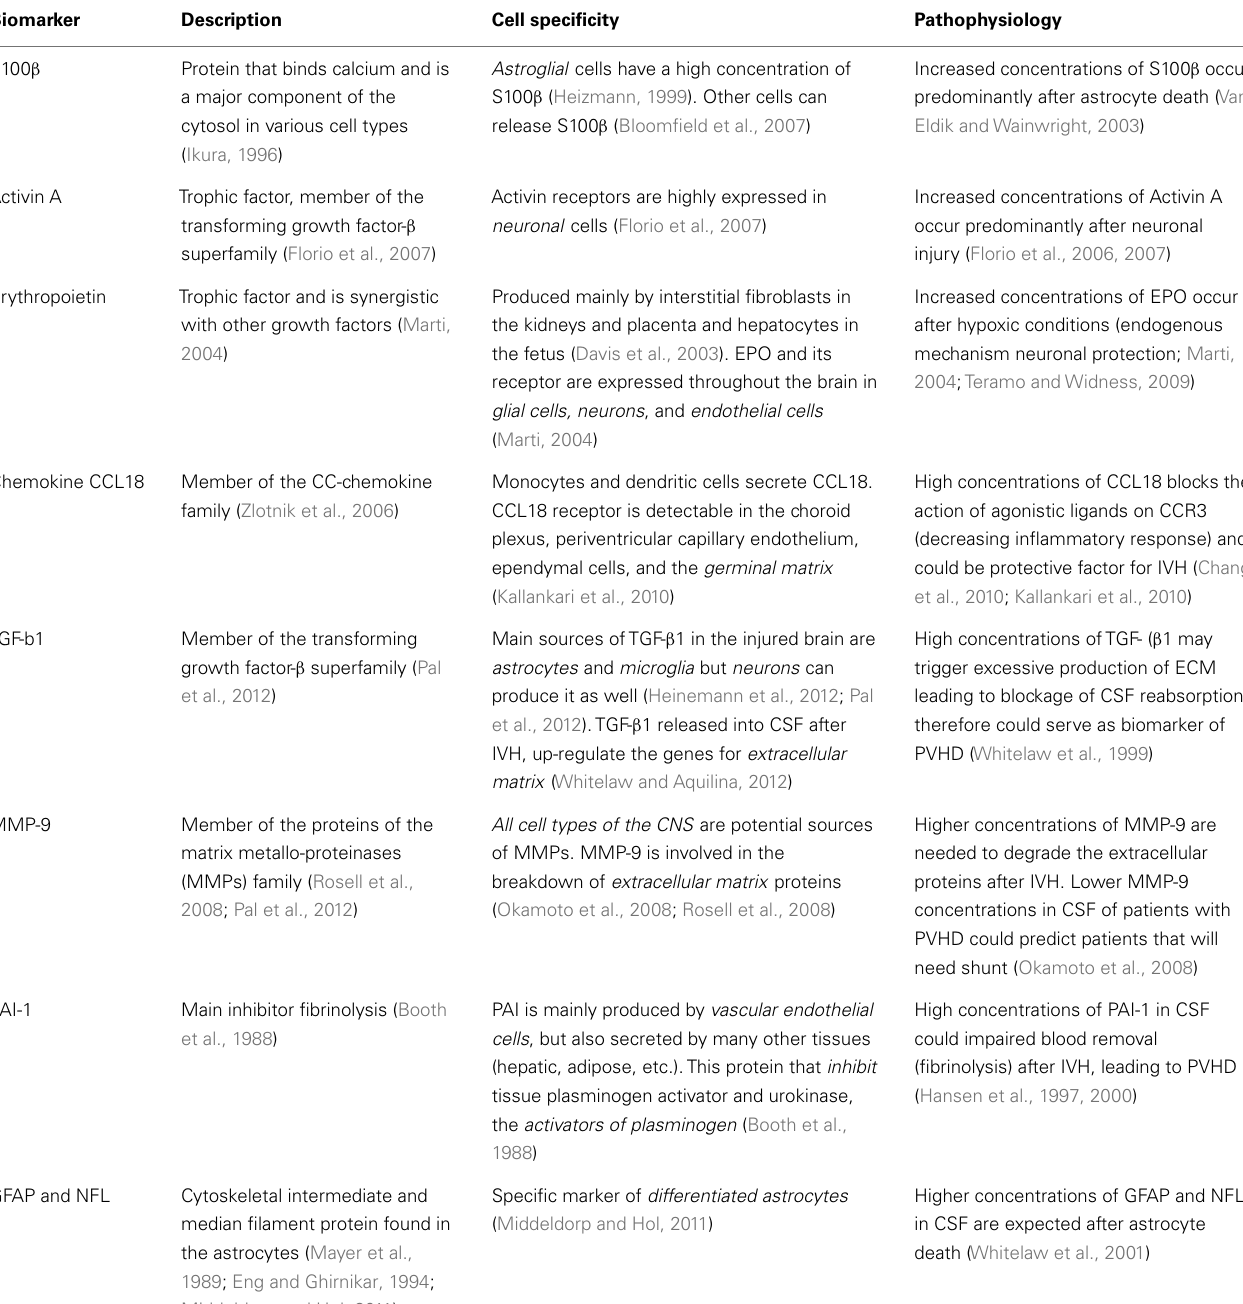
Table 1 | Summary of biomarkers